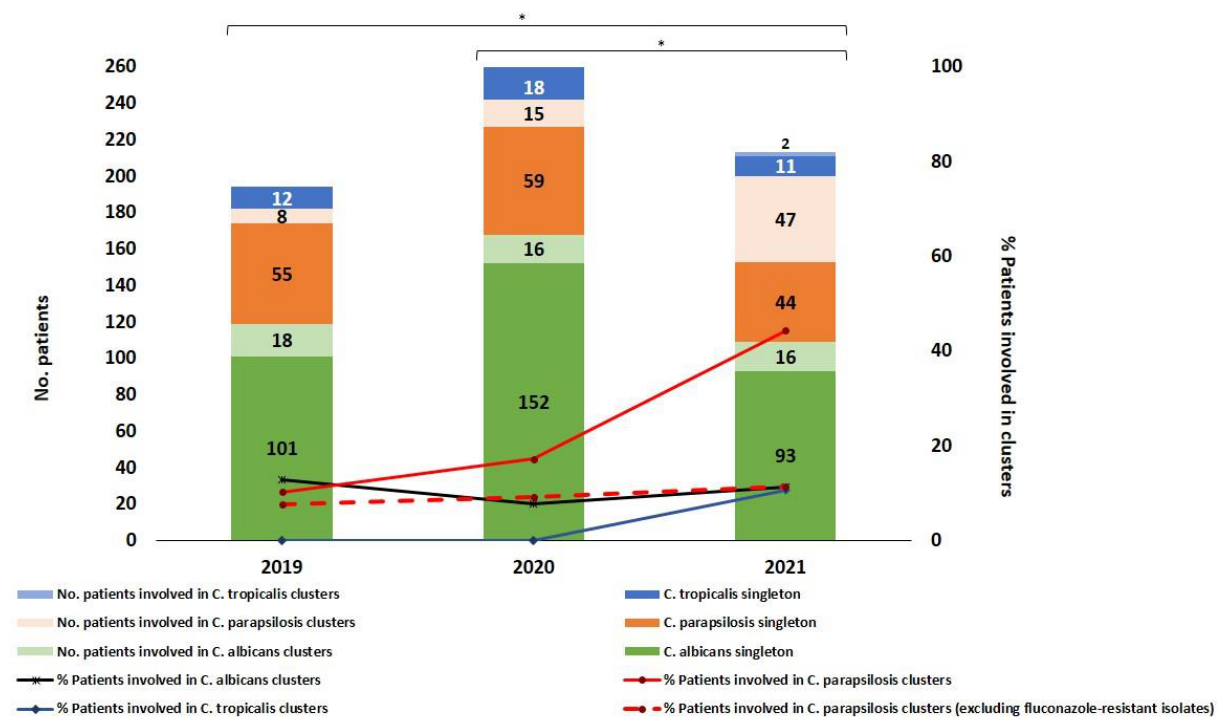
Figure 2. Numbers (and percentage) of patients involved in singleton and intra-hospital clusters per species over the study period. * Differences reaching statistical significance ( p <